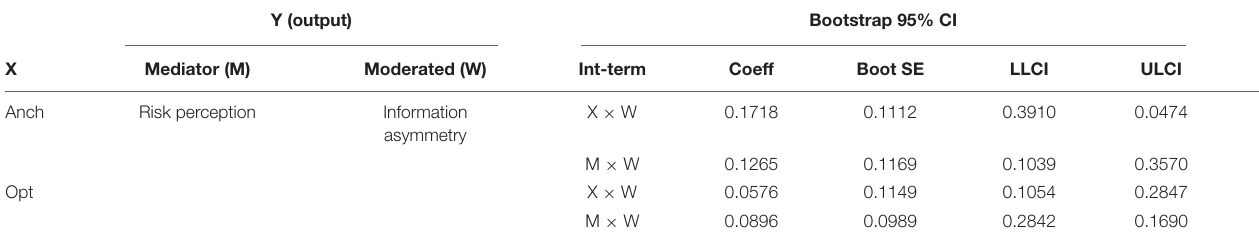
TABLE 6 | Mediated moderation effect of Information asymmetry.